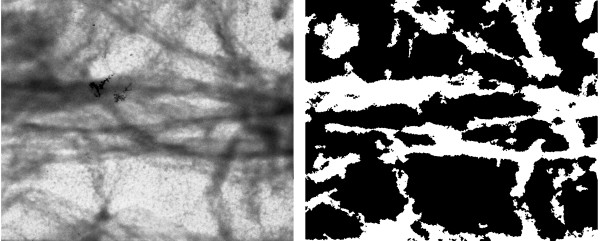
Result of the segmentation process in a representative control image.